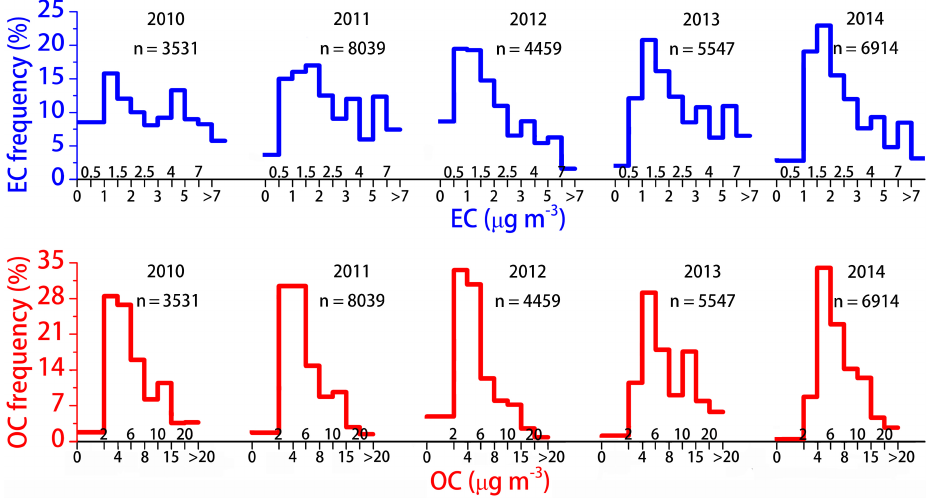
Figure 4. Frequency of EC and OC mass loadings in 5 different years in Shanghai. The frequency was calculated based on the average data points within a mass concentration internally of 0.5 and 2µgm − 3 for EC and OC,